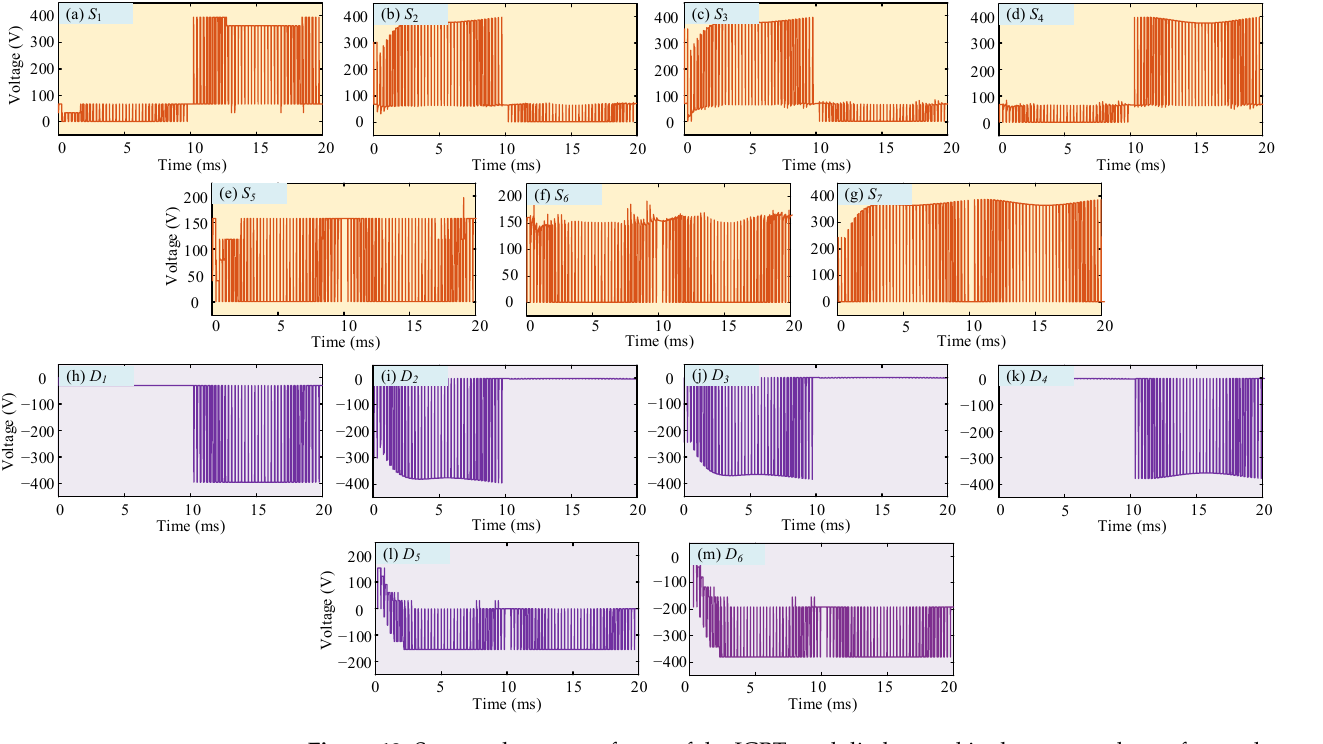
Figure 13. Stress voltage waveforms of the IGBTs and diodes used in the proposed transformer-less